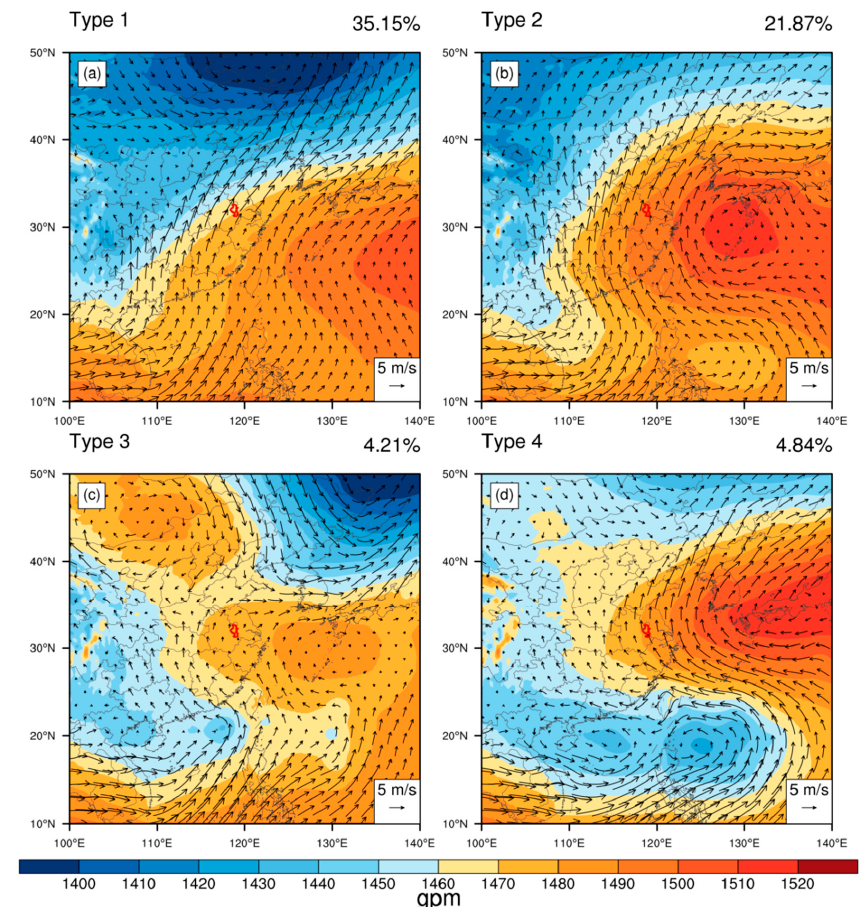
Figure 4. The 850-hHPa geopotential height (contours) and zonal/meridional wind (vector) patterns associated with the occurrence of HW events over 62 years at 1400 LST (local standard time) based on objective classification (the red outline indicates Nanjing and the number in the upper-right corner of each panel indicates the frequency of occurrence for each